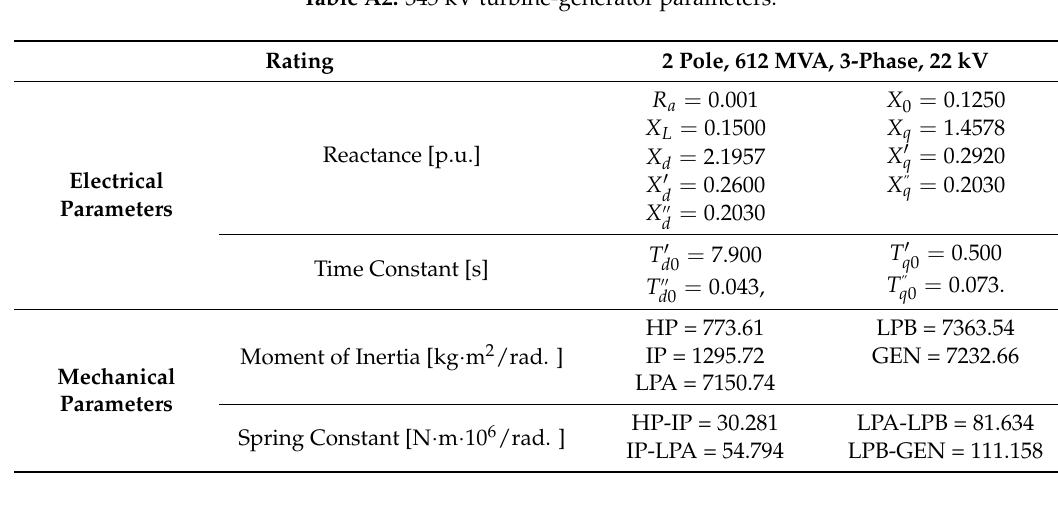
Table A2. 345 kV turbine-generator